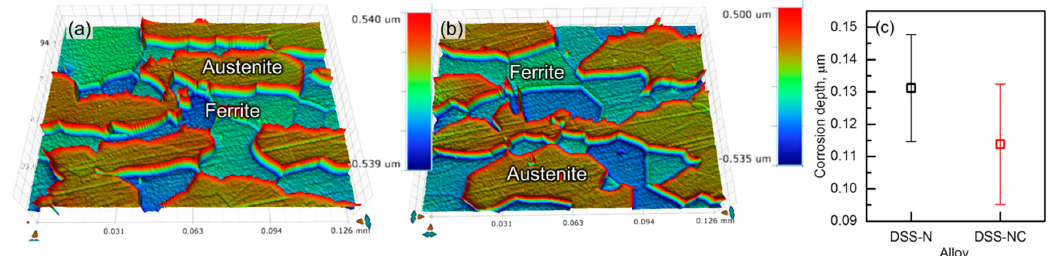
Figure 11. Three-dimensional images of the corroded surfaces of the ( a ) DSS-N and ( b ) DSS-NC. The images were obtained after immersion in a 0.2 M HCl solution at 25 °C for 40 minutes. ( c ) Variation in the corrosion depth of the two DSSs.